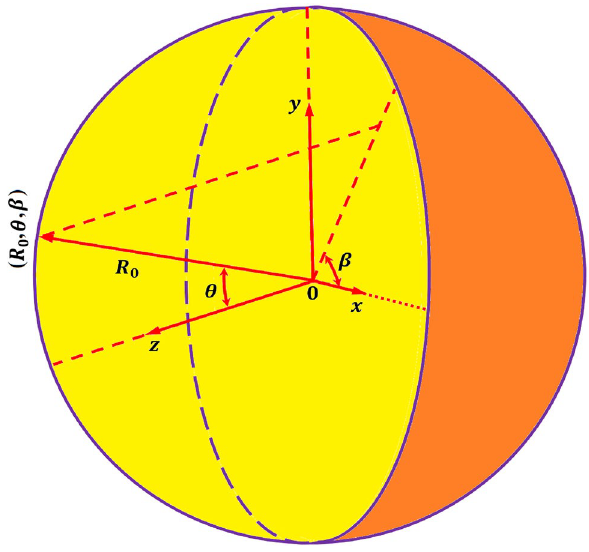
Figure 4. Representation of the coordinate system for the spherical enclosed acoustic